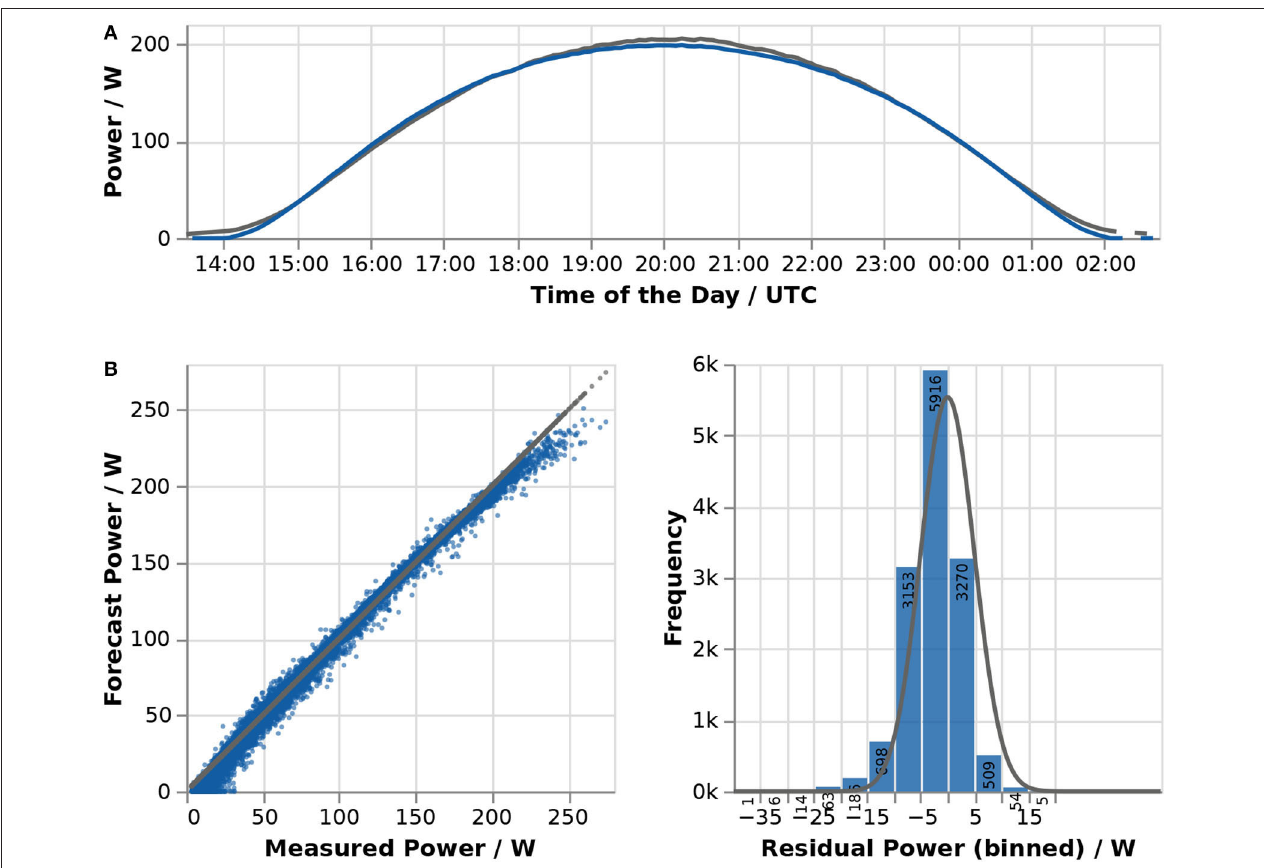
FIGURE 1 | Comparison of measurements and the forecast created using the physics-based model for the HIT05667-module in Eugene/Oregon by means of a run plot for May 5, 2013 (A) and scatter plot and histogram of residuals for three and a half months (March 15, 2013–June 25, 2013, B